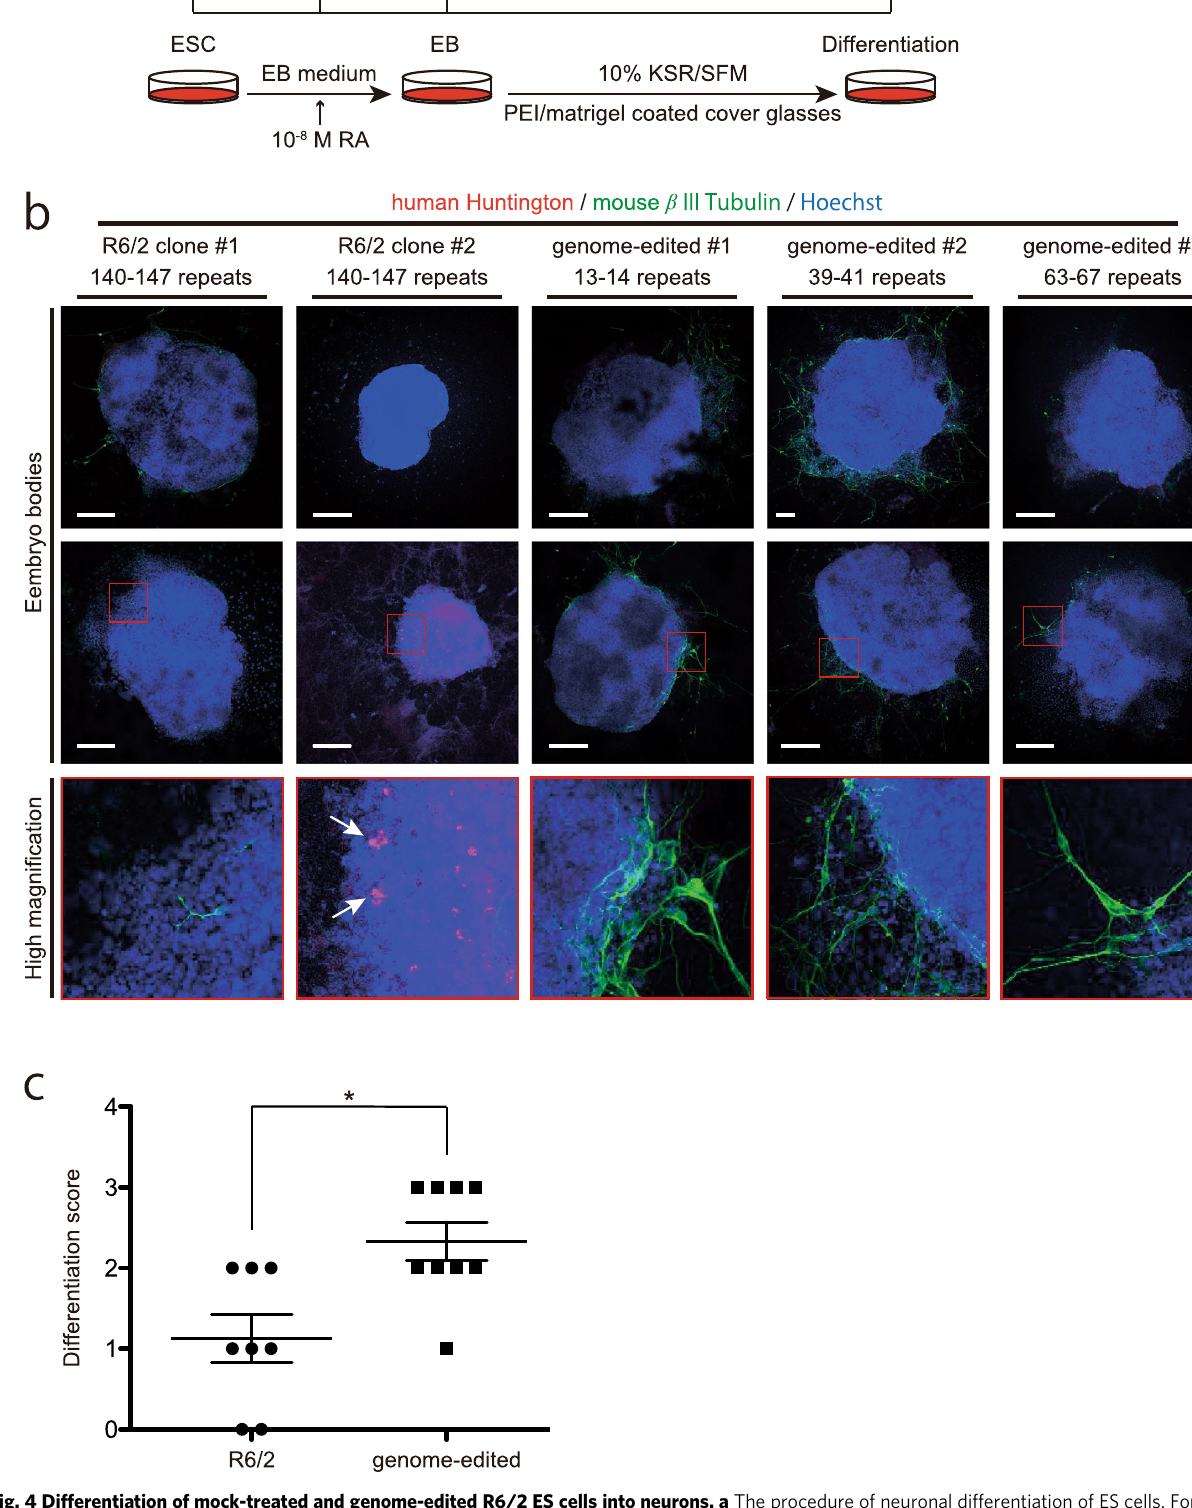
Fig. 4 Differentiation of mock-treated and genome-edited R6/2 ES cells into neurons. a The procedure of neuronal differentiation of ES cells. For in vitro differentiation assay, we used ES clones transfected with prototype SpCas9-NG (not published), not ES clones described in Fig. 2. b Immunostaining of differentiated embryoid bodies. White arrows in the high magni fi ed image of R6/2 clone #2 indicate HTT aggregates. All scale bars indicate 100 µ m: the EB in genome-edited #2 (top) was almost twice larger than the others. c The differentiation scores based on a percentage of the β III tubulin staining in the circumference of embryoid bodies; 1: 0 – 25%; 2: 25 – 50%; 3: 50 – 75%; 4: 75 – 100%. Statistical analysis was performed using a two-tailed Mann – Whitney U- test ( p -value =